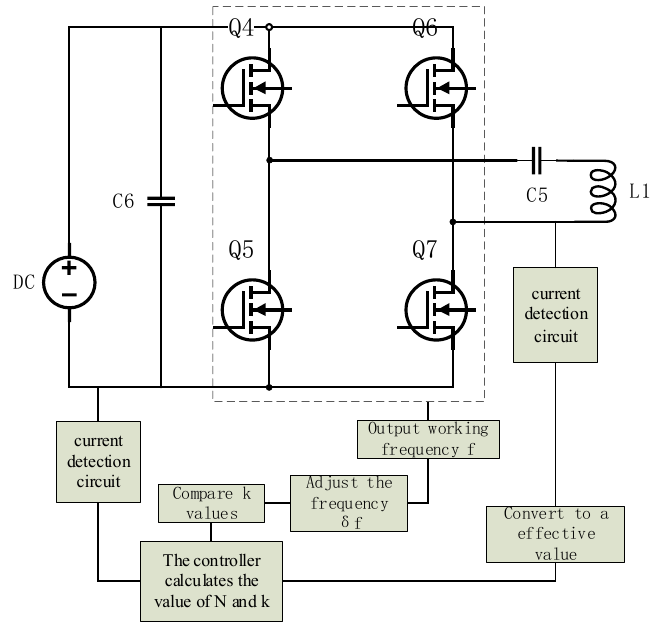
Figure 7. Resonant frequency adjustment structure diagram based on inverter current RMS.